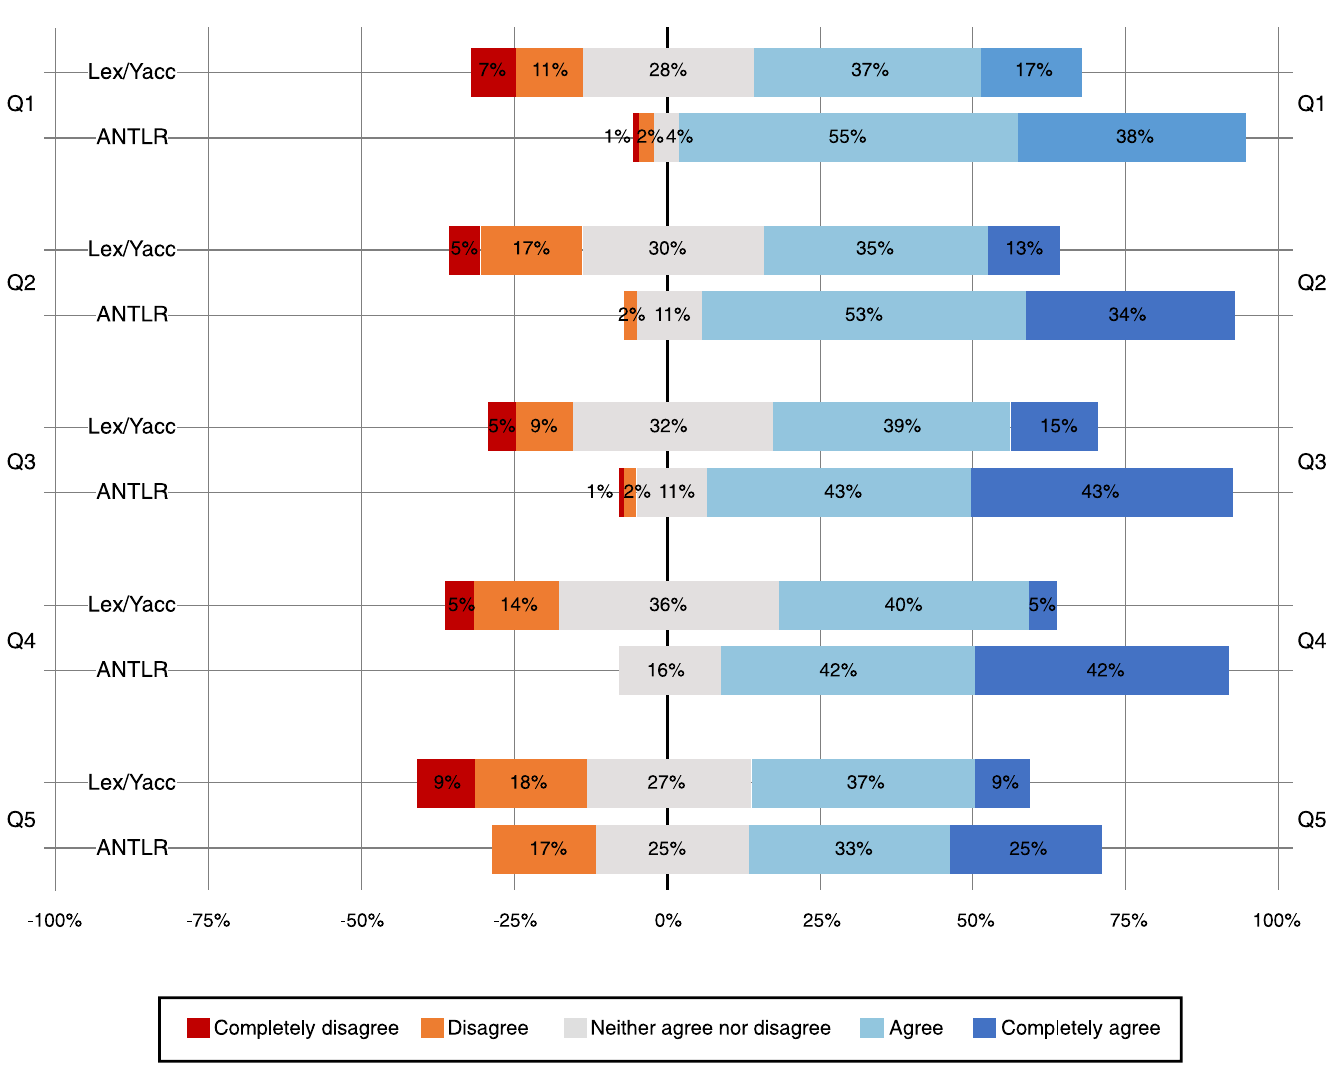
Fig 1. Comparison of the Likert-scale answers of the Lex/Yacc and ANTLR